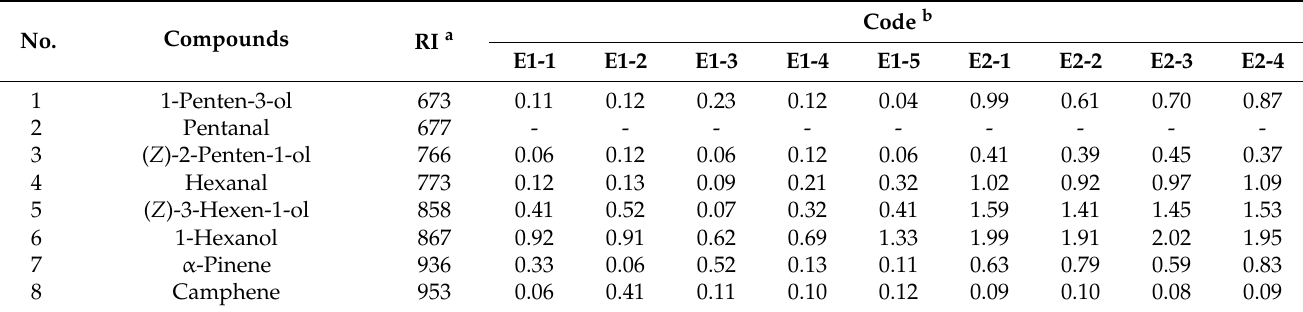
Table 4. Volatile compounds detected in the analyzed samples of cryptic species E (genetic lineage E1 and E2) of the A. pinguis. No.